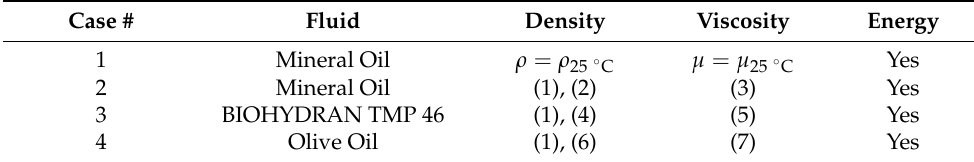
Table 6. Fluid models considered in the simulation